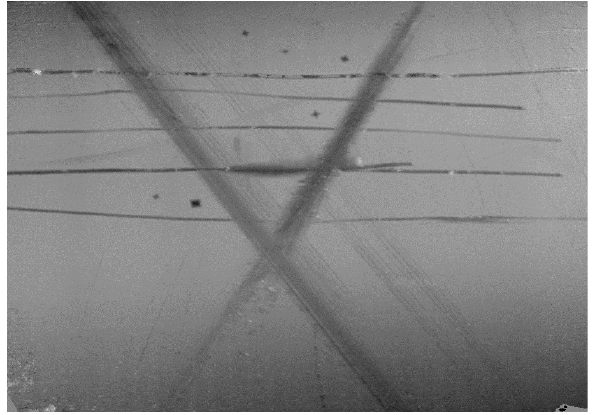
Figure.10.Depth map with shading